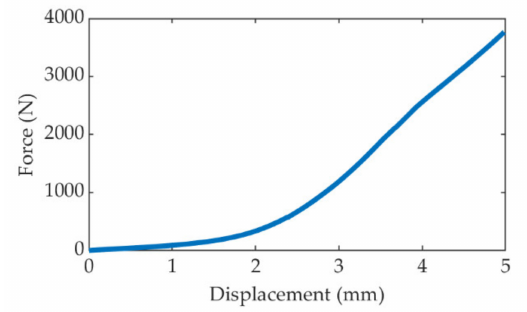
Figure 12. Axial stiffness of the DN25 braided corrugated hose.